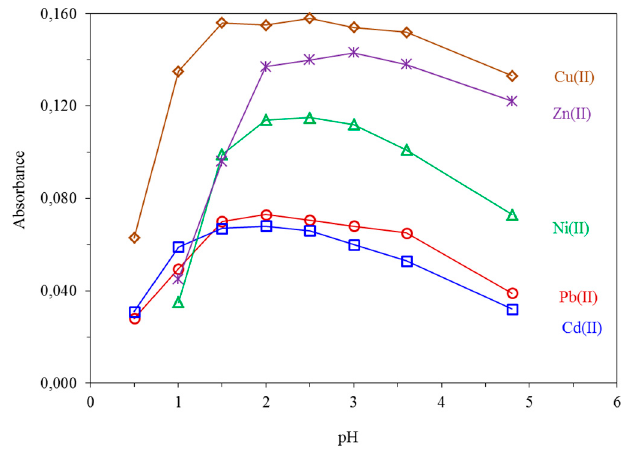
Figure 3. Effect of pH on the absorbance of 10.0 μ g L − 1 Cu(II), 20.0 μ g L − 1 Ni(II), 5.0 μ g L − 1 Zn(II), 50.0 μ g L − 1 Pb(II) and 10.0 μ g L − 1 Cd(II). All other parameters as given in Table